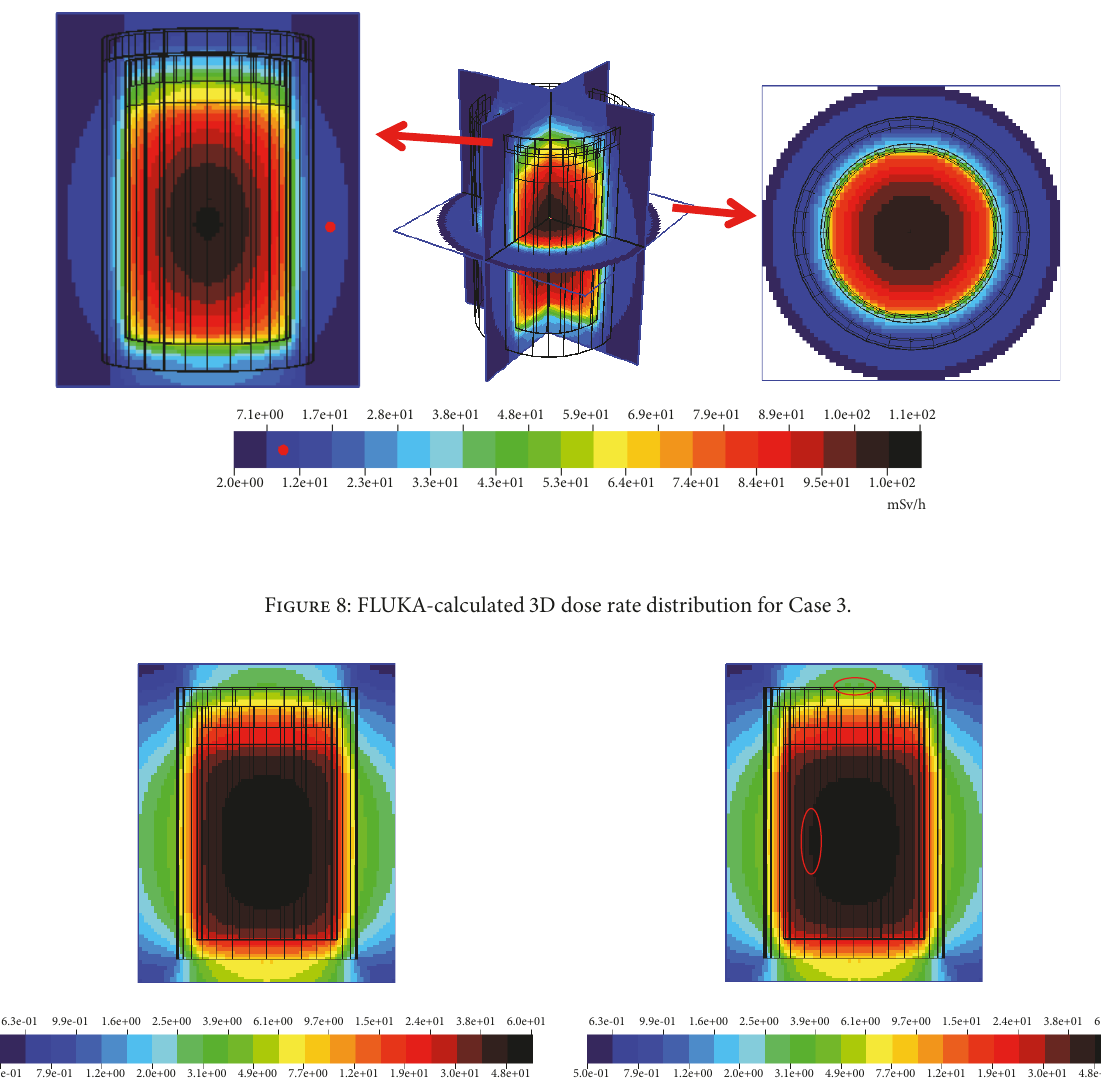
Figure 9: The front views of the dose rate distributions for Case 4 by direct (a)/optimized (b) calculation